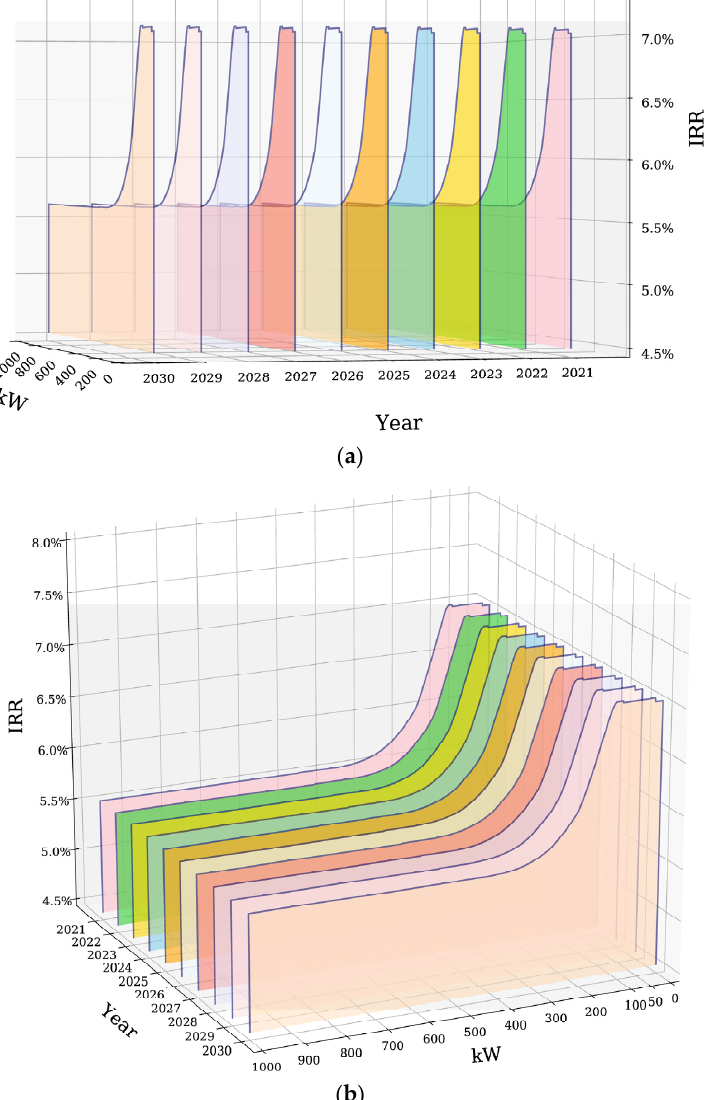
Figure 6. Predicted equity IRRs (Internal Rate of Returns) for rooftop PVS with capacity 1 to 1000 kW (2021–2030), from different angles ( a , b ) Source: